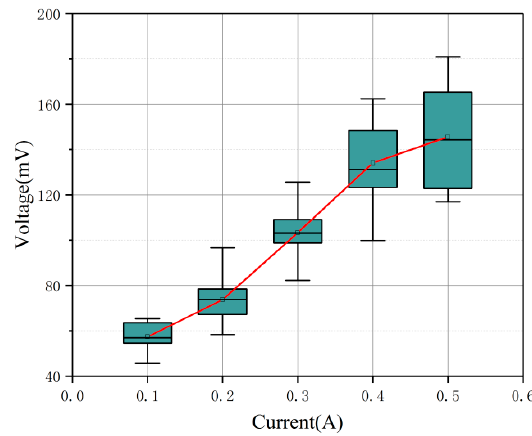
Figure 9. Variation in the output voltage with the current.